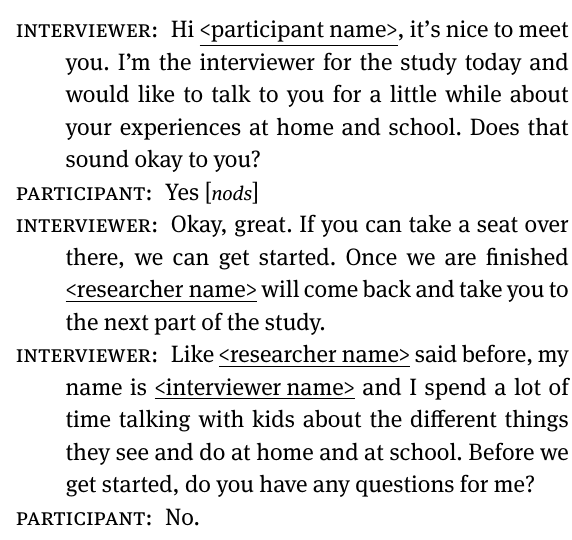
about a specific activity. The "producer" was also responsi- ble for enabling back-channeling (i.e., head-nodding) and participant tracking during robot